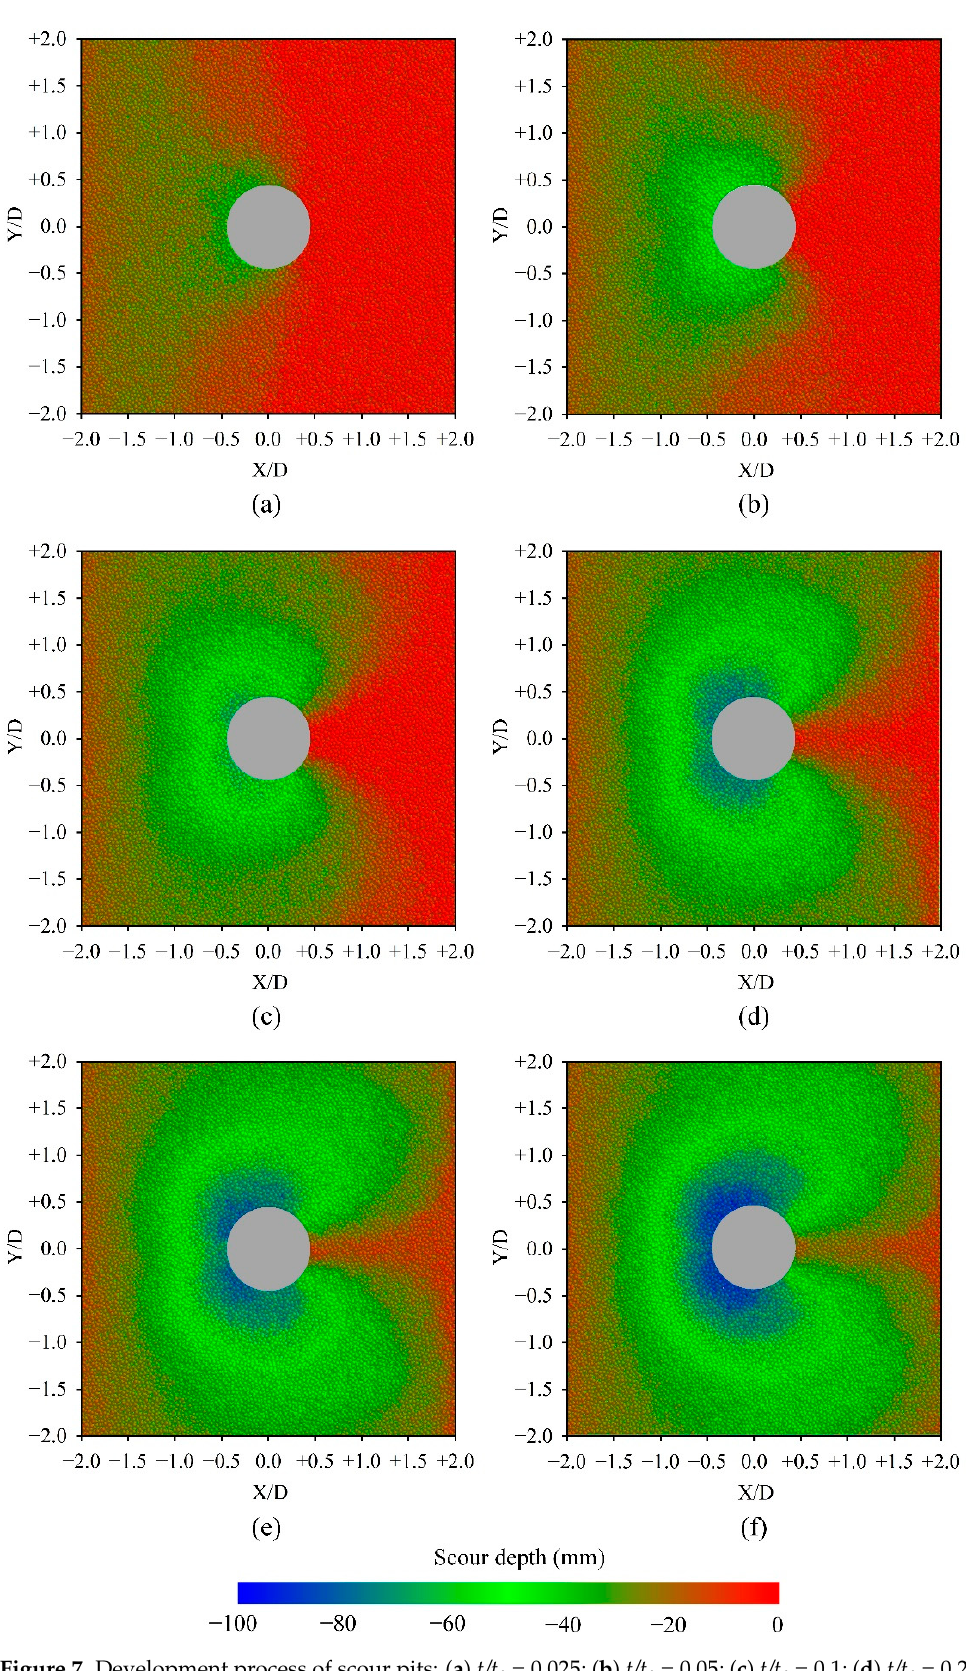
Figure 7. Development process of scour pits: ( a ) t/t e = 0.025; ( b ) t/t e = 0.05; ( c ) t/t e = 0.1; ( d ) t/t e = 0.25; ( e ) t/t e = 0.5; and ( f ) t/t e = 1. t e represents the time corresponding to the local scour equilibrium.